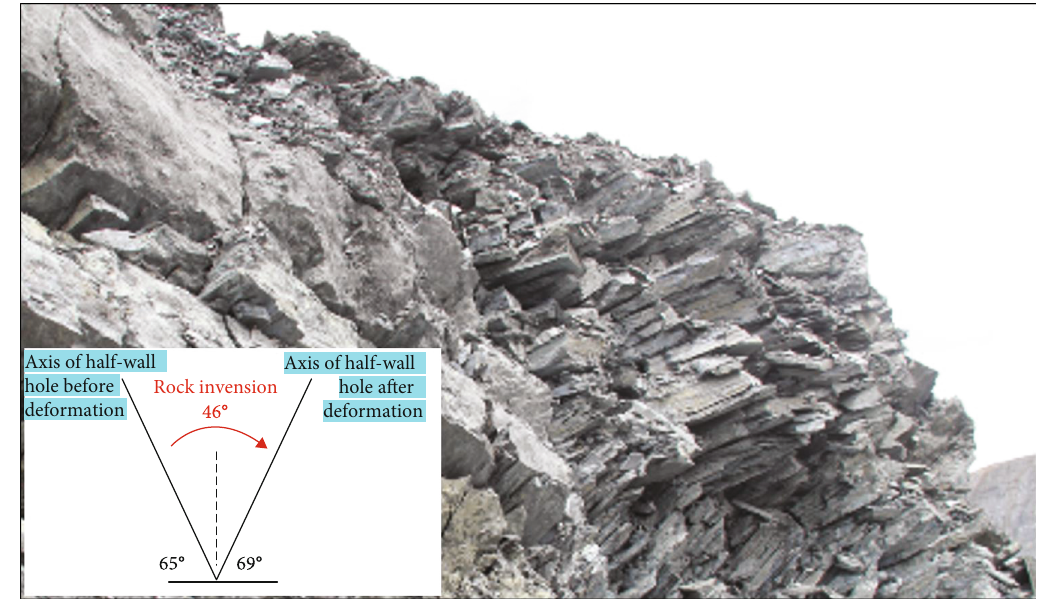
Figure 3: Typical cross section of mining pit [28].